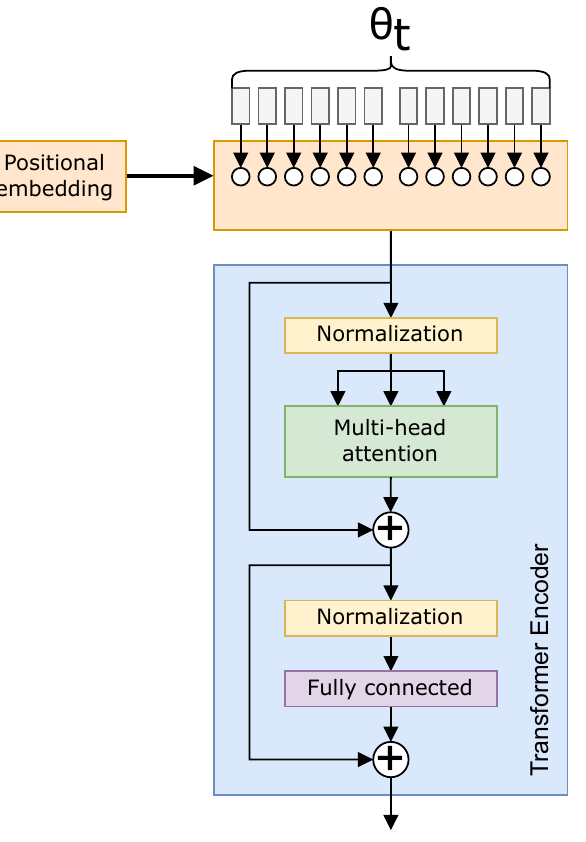
Figure 3. Example Vision Transformer (ViT) where our input data are positionally embedded prior to passing into the Transformer, being Equations